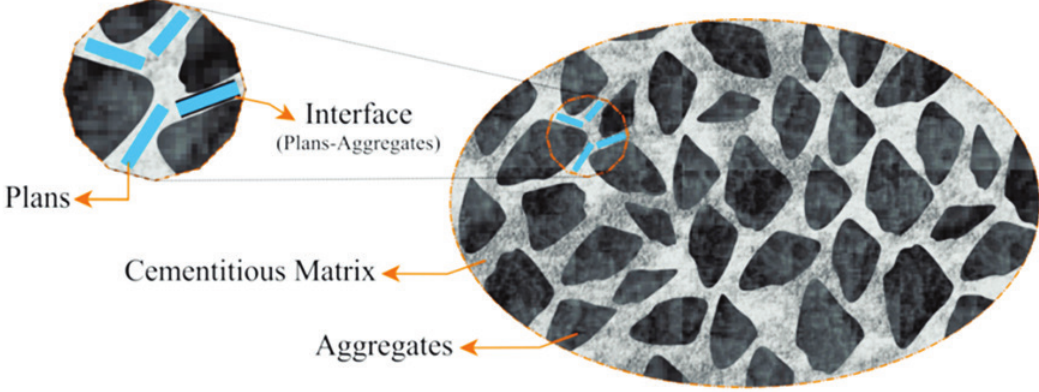
Association between the plans of discontinuities and the solid concrete microstructure